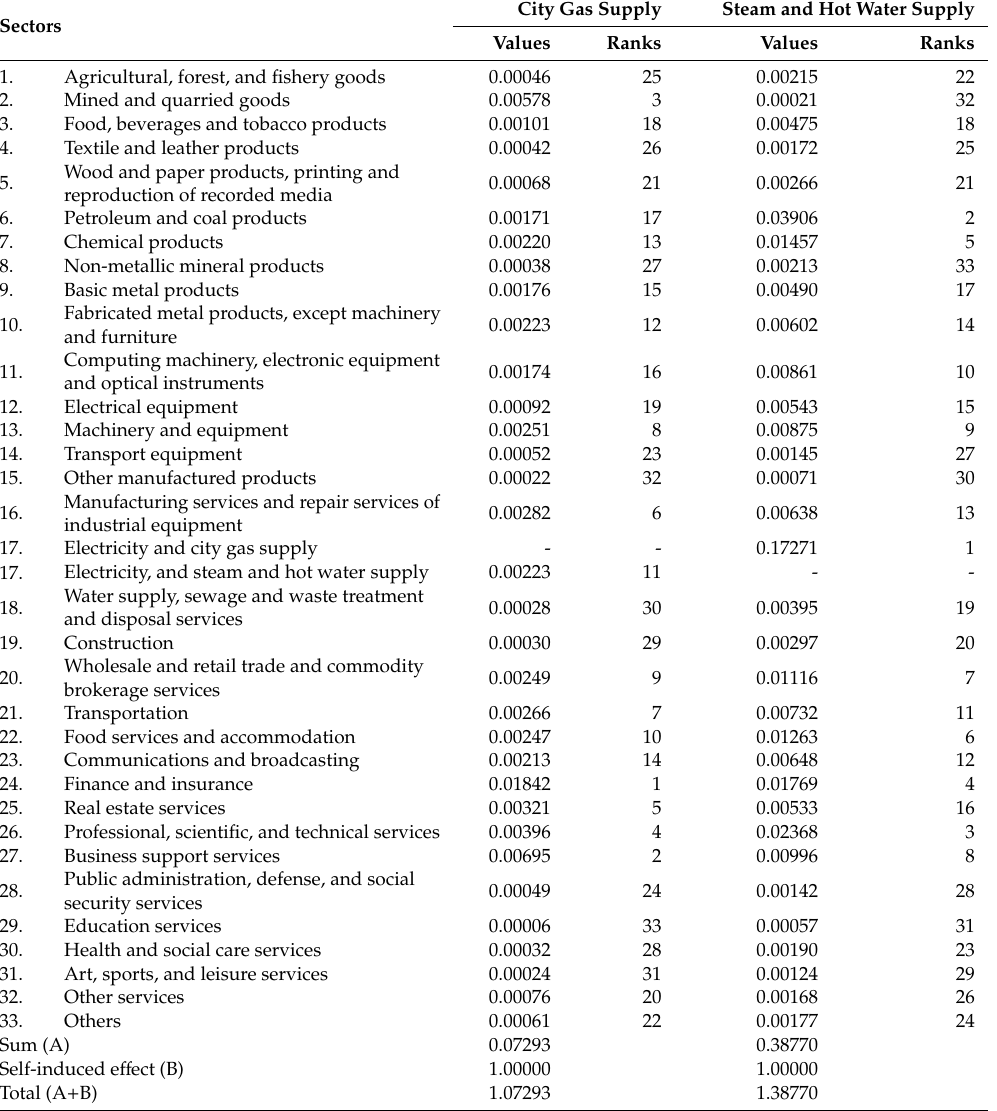
Table 2. Production-inducing e ff ects of steam and hot water supply and city gas supply